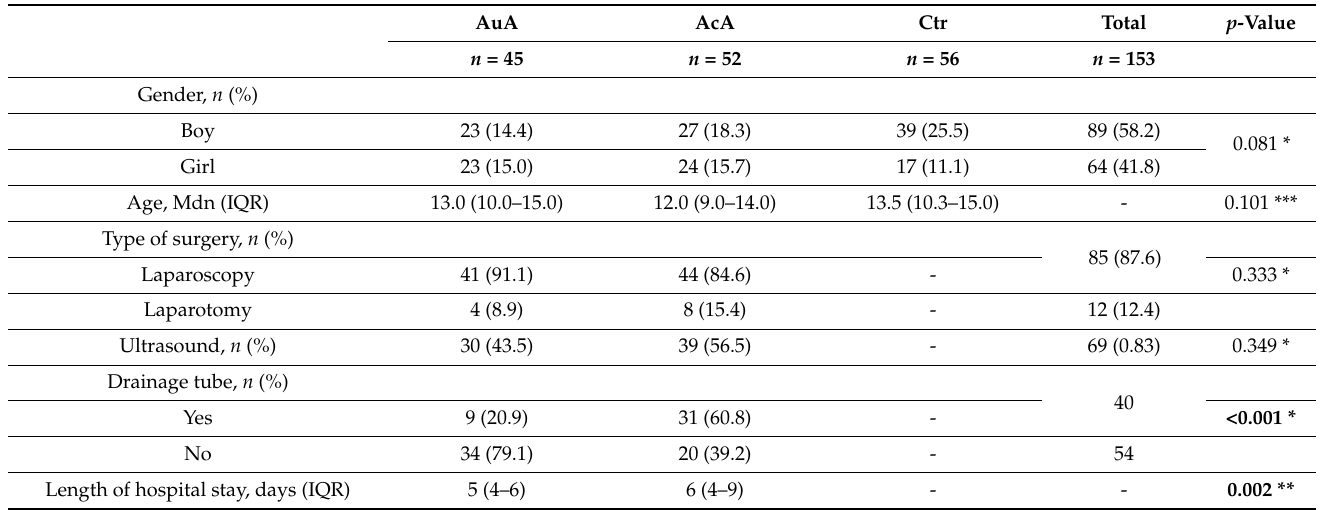
Table 1. Demographics and clinical characteristics of cohort